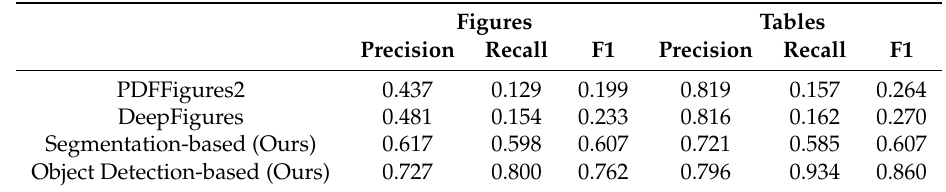
Table 4. Results of running the Evaluation on Mixed-Large-Test when presupposing the semantic-oriented definition system.